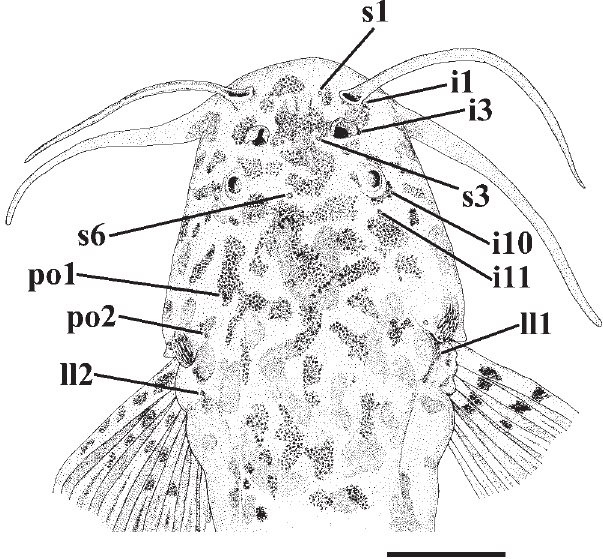
Fig. 4. Head of Trichomycterus maracaya in dorsal view (LIRP 4381), 51.3 mm SL, paratype, showing pattern composed of two-layered blotches and spots (densely packed lower layer drawn as regularly spaced lighter dots, and loosely grouped upper layer drawn as irregularly spaced darker